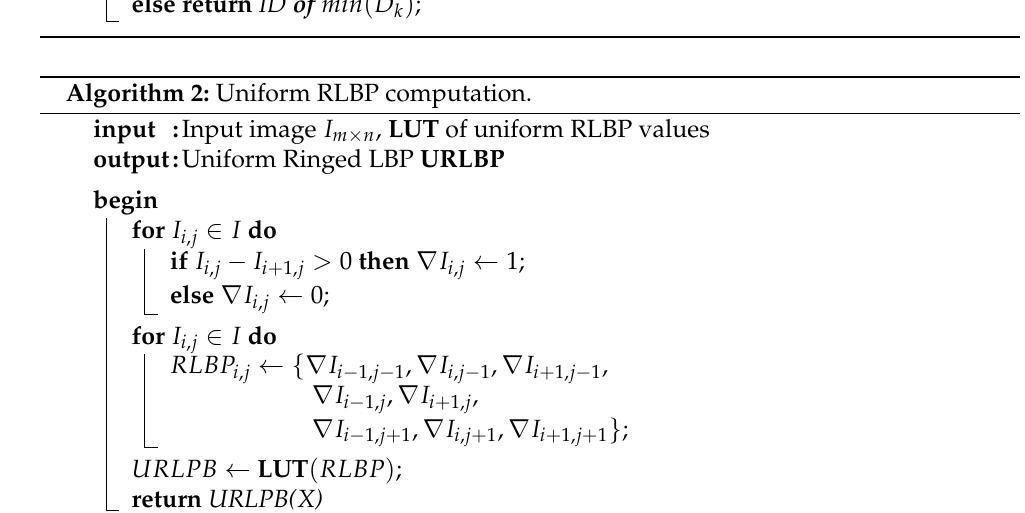
Algorithm 2: Uniform RLBP